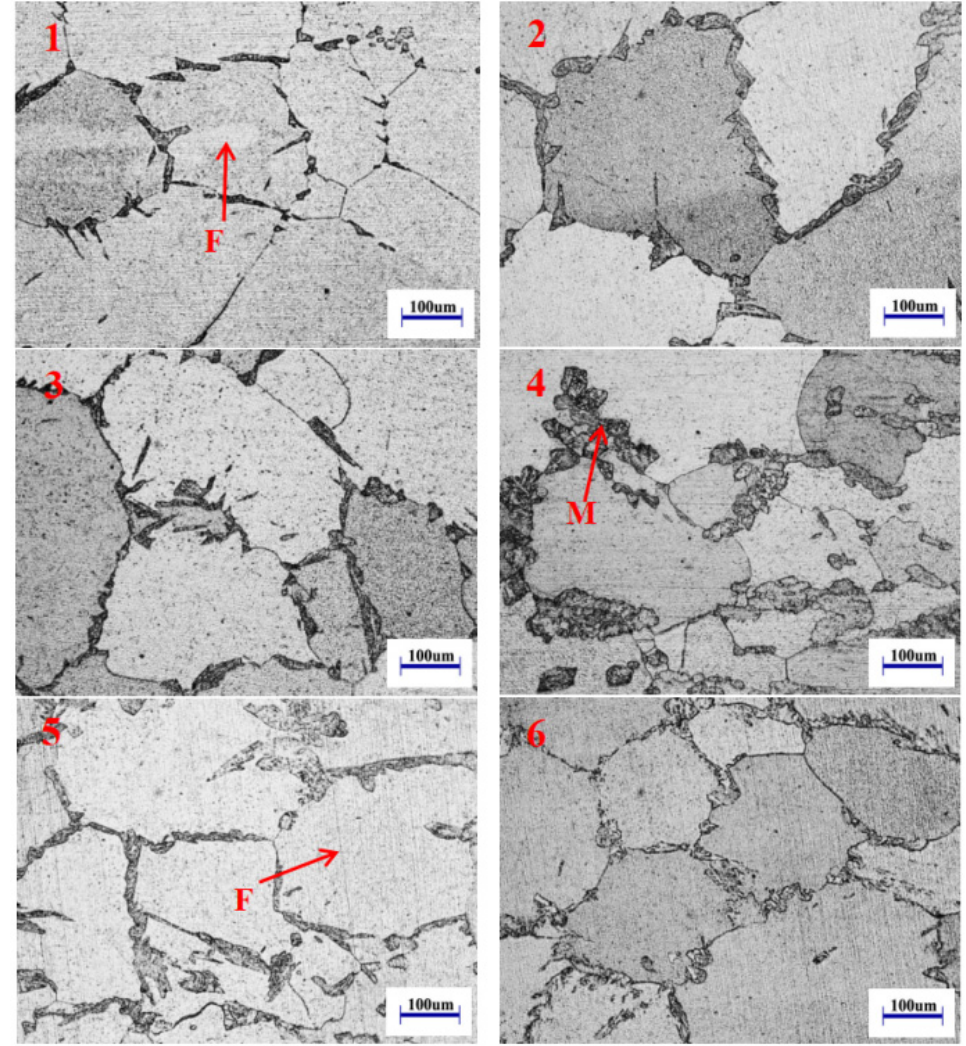
Figure 14. Microstructure of coarse grain zone at different holding times: ( 1 ) 30 s, ( 2 ) 2 min, ( 3 ) 5 min, ( 4 ) 15 min, ( 5 ) 1 h, ( 6 ) Complete recrystallization .